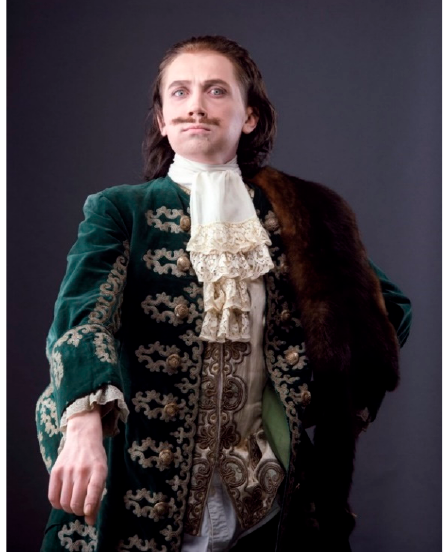
Figure 5. Vlad Mamyshev-Monroe. From the series “Life of Remarkable Monroes” (1995). https://vmmf.org/series/view?id=1#work-series-1-1 (accessed on 11 September 2022).